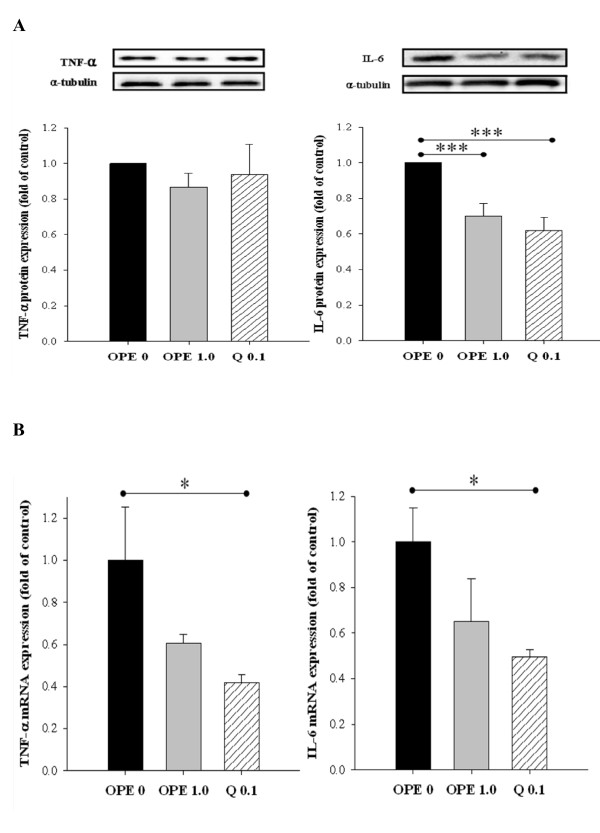
Immunoblot analysis of protein levels (A) and gene expression levels (B) of TNF-α and IL-6 in liver of HFD/STZ-induced diabetic rats. Levels of TNF-α protein and IL-6 protein were measured normalized against α-tublin, and expressed as fold of control. The mRNA expression levels were determined by quantitative RT-PCR, normalized against β-actin, and plotted relative to those of diabetic control rats. Data are expressed as means ± SE, (n = 7 for each group). Comparisons were done between the control group and each individual treated group by Dunnet's multiple comparison test. *Different from control, P < 0.05, ***different from control, P < 0.005